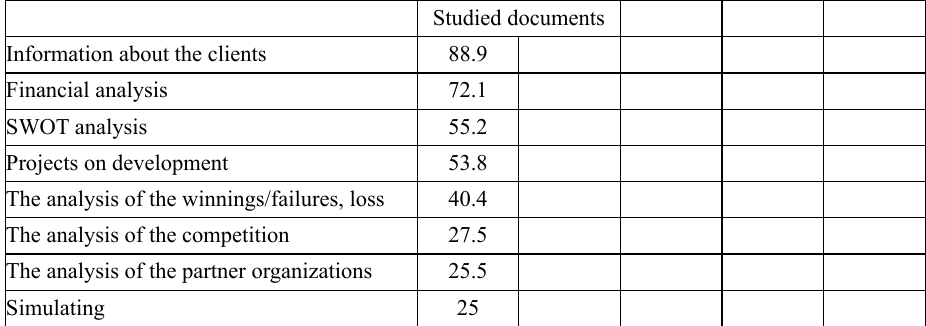
Table 1.The SCIP database of the documents, which are usually studied